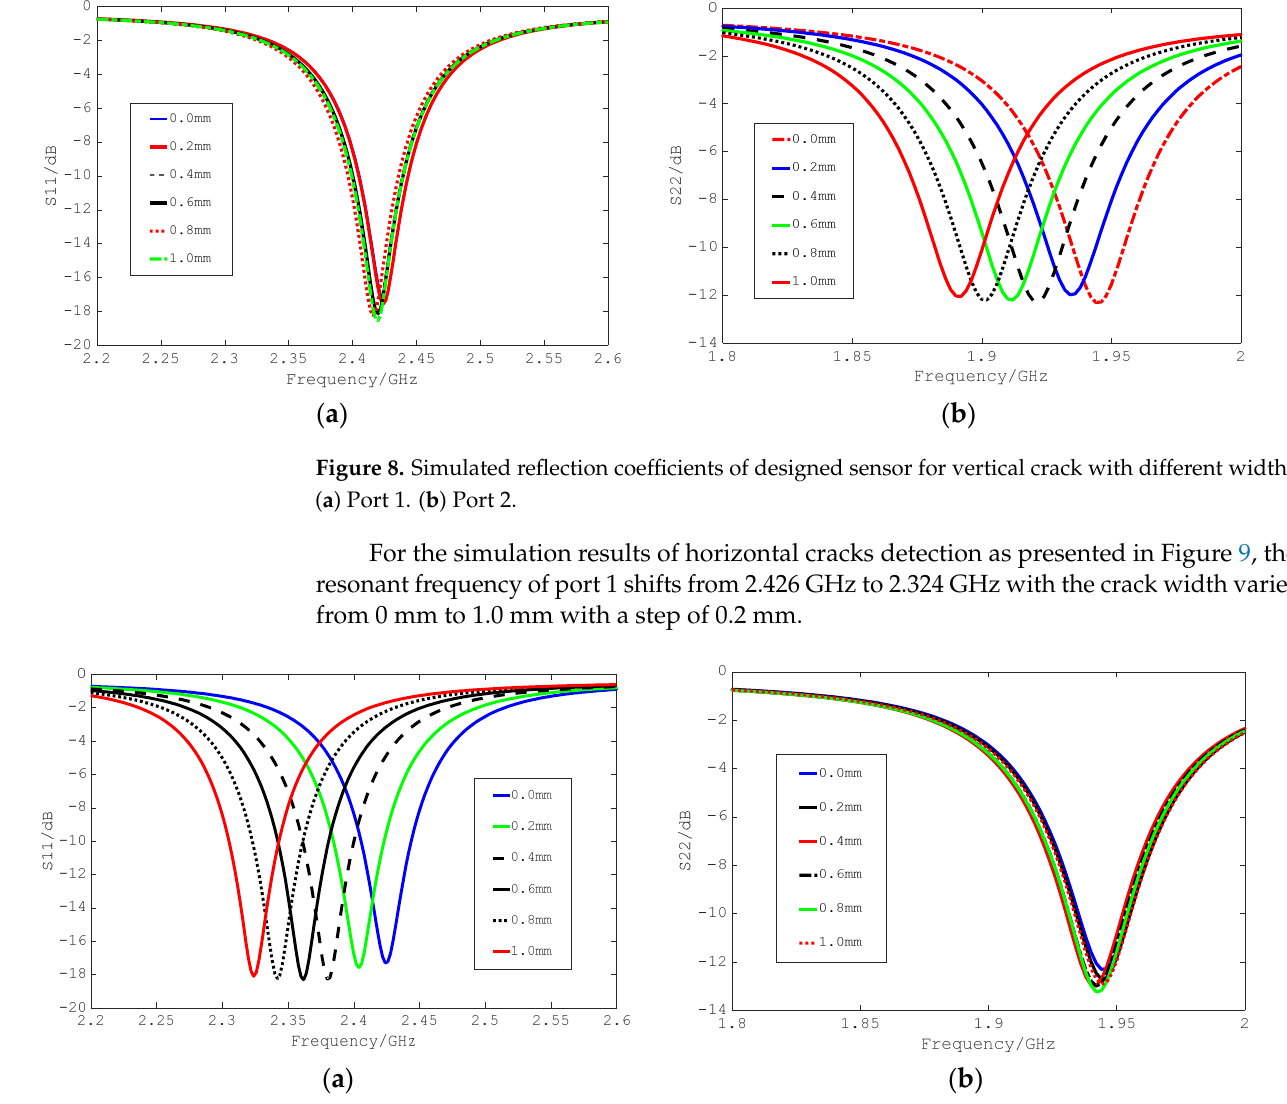
Figure 9. Simulated reflection coefficients of designed sensor for horizontal crack with different widths. ( a ) Port 1. ( b ) Port 2.